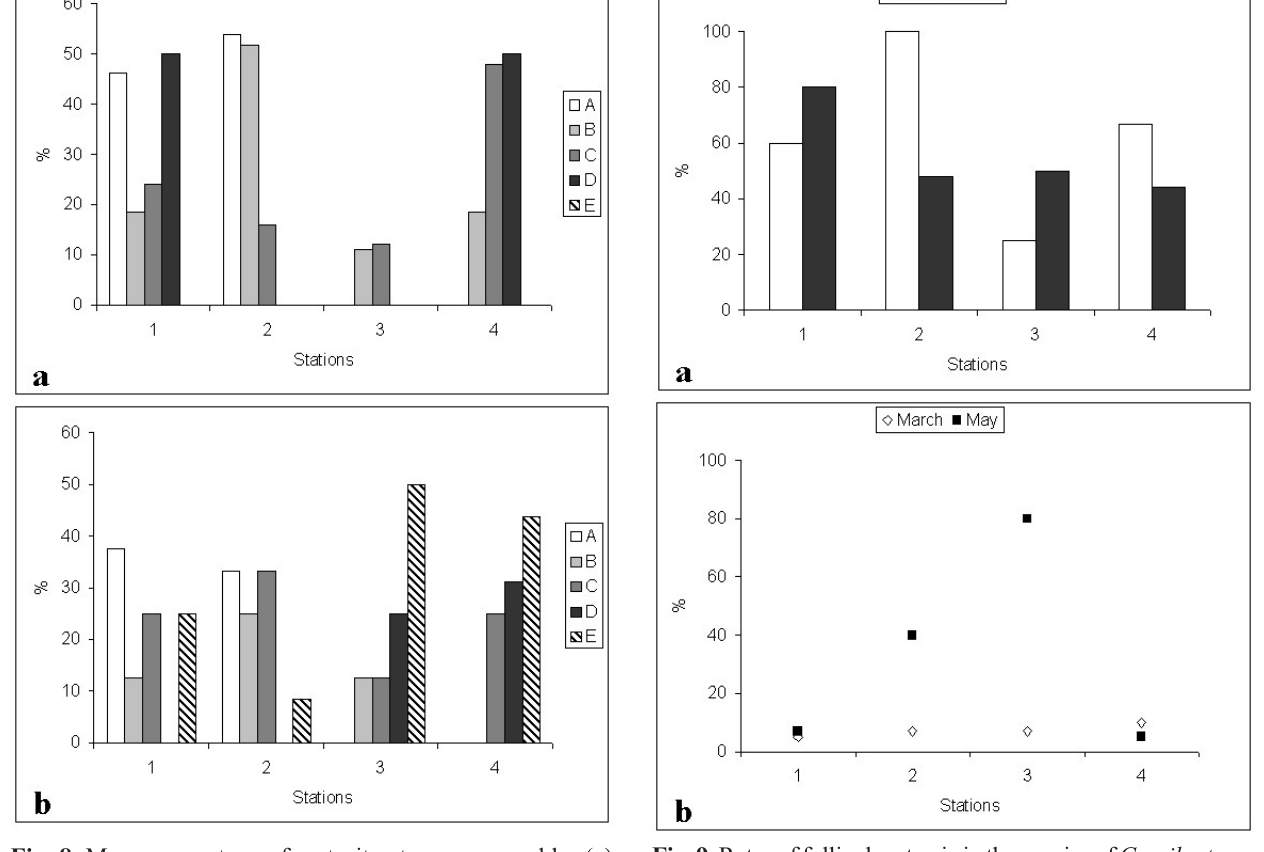
Fig. 8 . Mean percentage of maturity stages assessed by (a) gross classification and (b) histological classification for C. spilopterus.